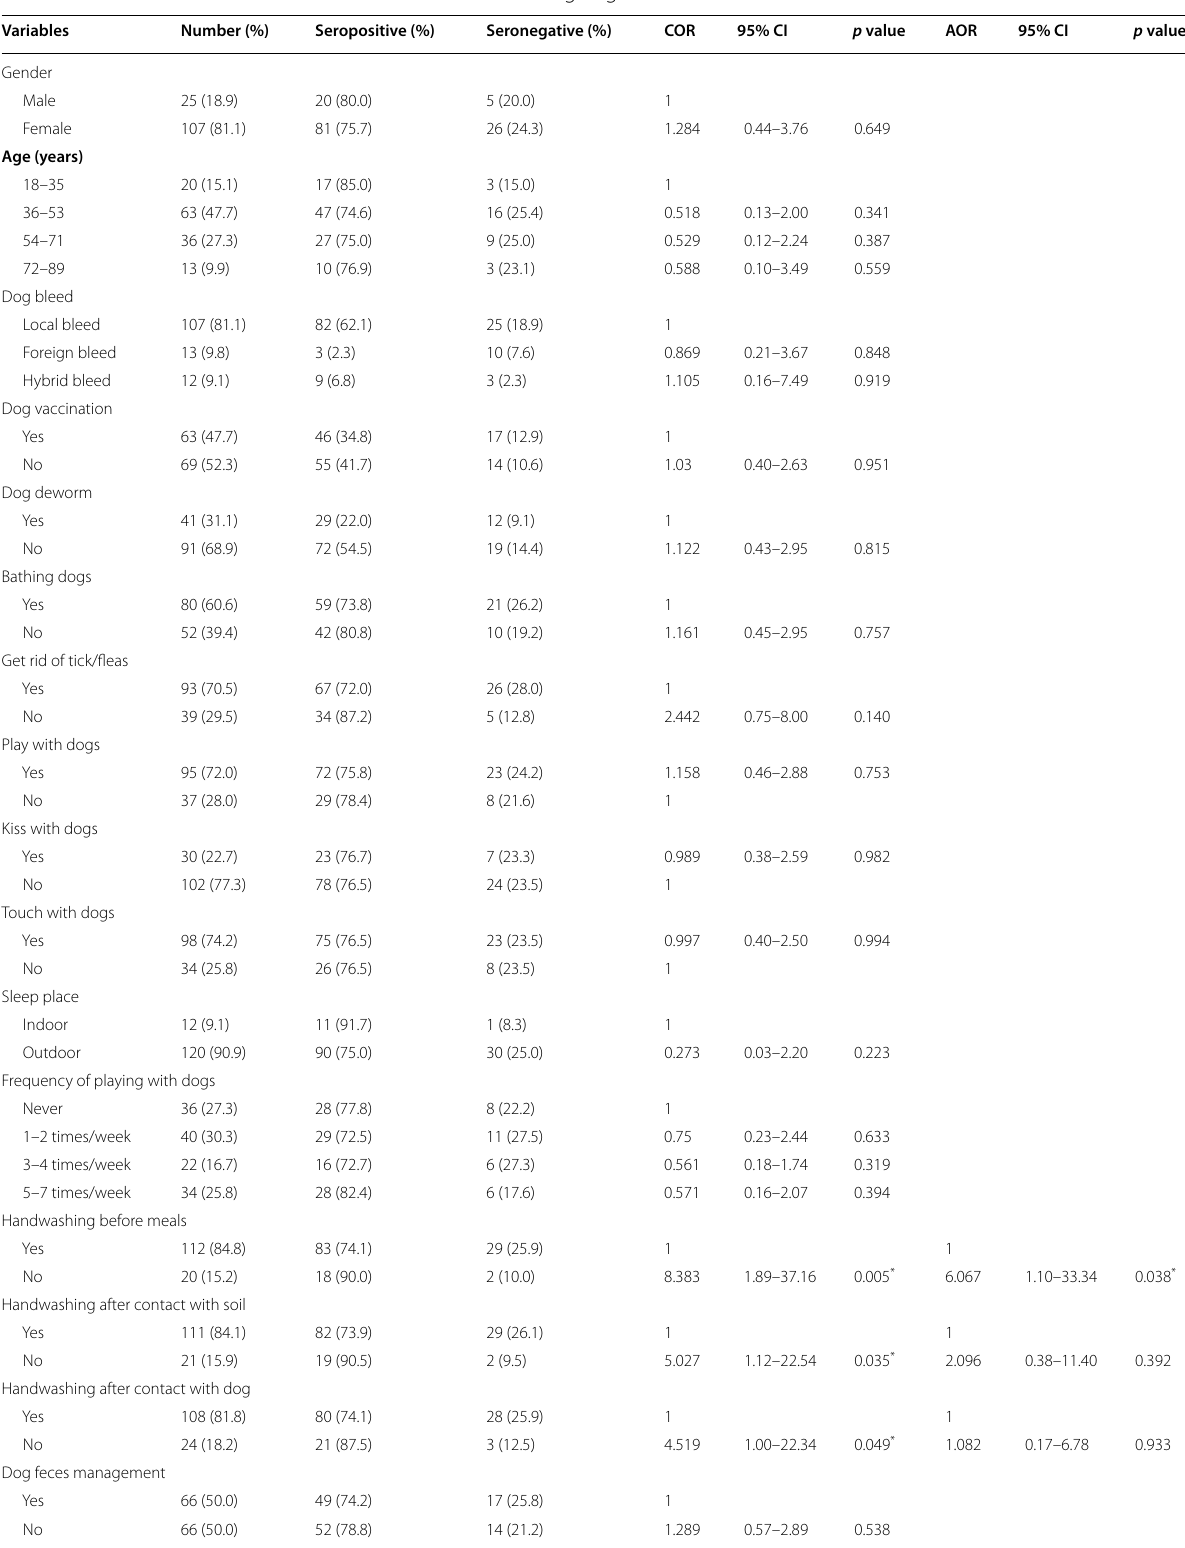
Table 3 Factors associated with Toxocara canis infection among dog